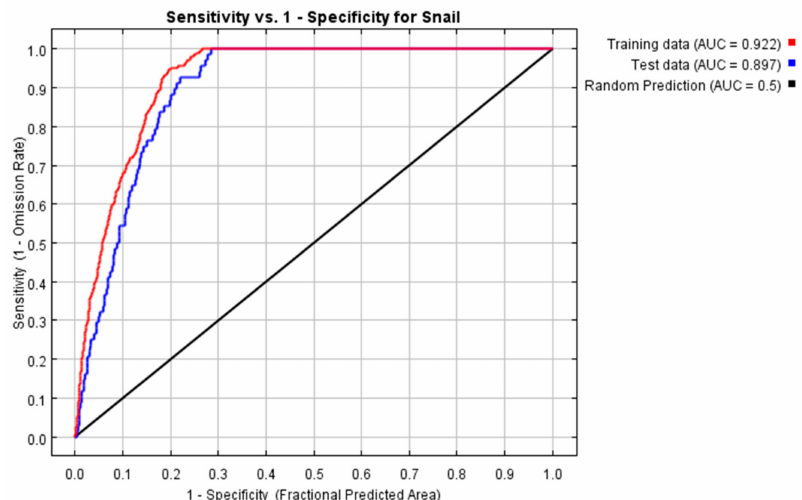
Figure 5. Values from the AUC (area under curve) testing.